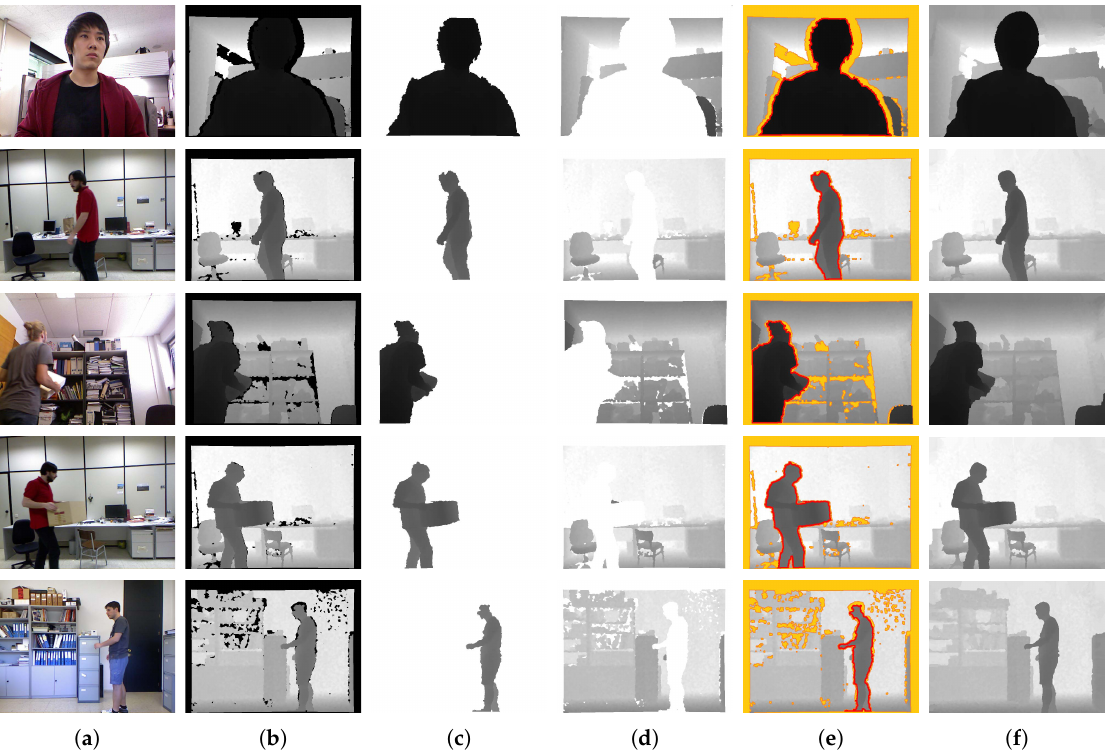
Figure 15. Examples of depth enhancement using the proposed method. ( a , b ) are the color and original depth images, respectively; ( c , d ) are the object and background depth regions obtained by the proposed method, respectively; ( f ) shows the enhanced depth images obtained by the GrowFill algorithm using ( e ) as the input depth image; the yellow marker in ( e ) indicates the original depth holes; red and orange markers in ( e ) show the expanded regions by using the morphological operations based on ( c , d ), respectively.